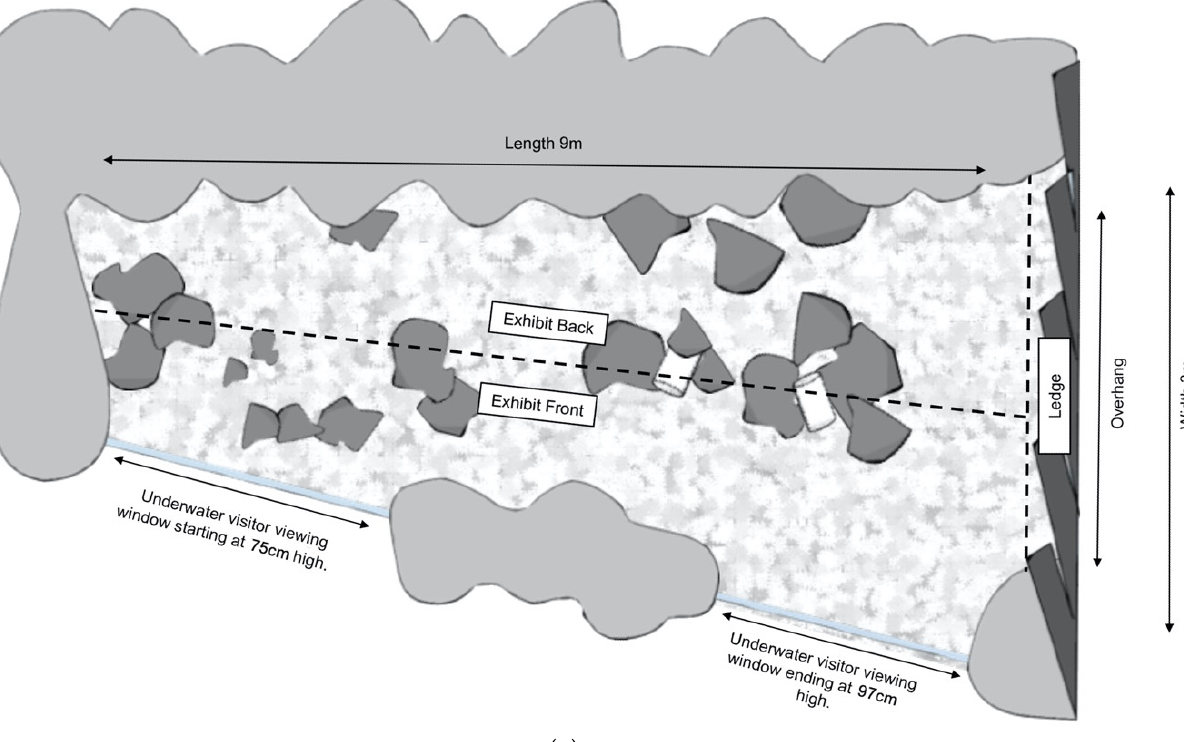
( b ) Figure 1. ( a ) The tank at Melbourne Zoo where all species were housed prior to renovations. Dark grey shapes represent large rocky structures (without shelter), two PVC pipes for shelter are represented by white cylinders. ( b ) The tank at Melbourne Zoo where all species were housed post renovations. Dark green and light green shapes represent rocky struc ‐ tures that are textured and provide multiple places for shelter, Multi ‐ colour shapes represent the mock seaweed installed in the exhibit that provides complexity and shelter. The background colour change represents a change in substrate from thick shell grit to fine coral sand. For both (a,b) light grey areas around the outside of the tank represent mock rock and